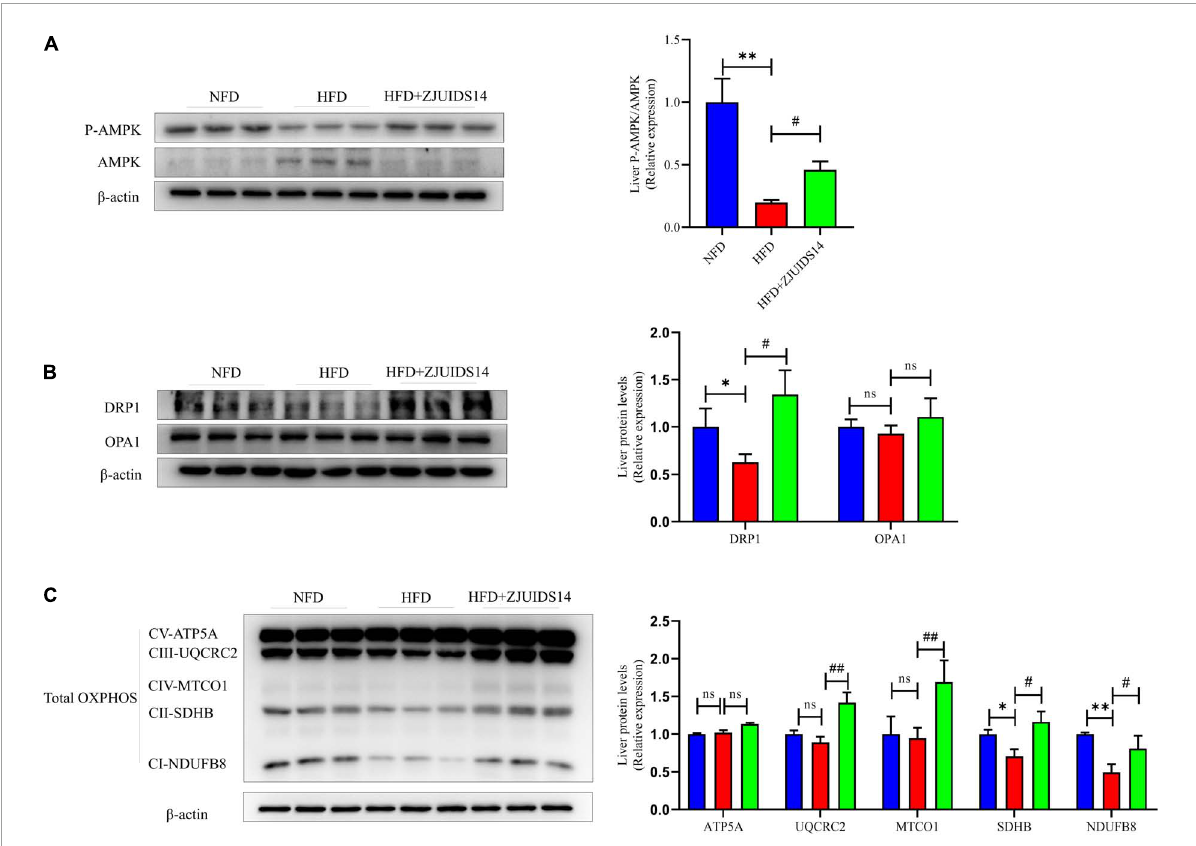
FIGURE5 Lactobacillus plantarum ZJUIDS14 administration improves mitochondrial function in HFD fed mice. Protein levels of (A) P-AMPK and AMPK, (B) DRP1 and OPA1, (C) OXPHOS. ∗ P < 0.05, ∗∗ P < 0.01 vs NFD group; # P < 0.05, ## P < 0.01 vs HFD group. ns, not